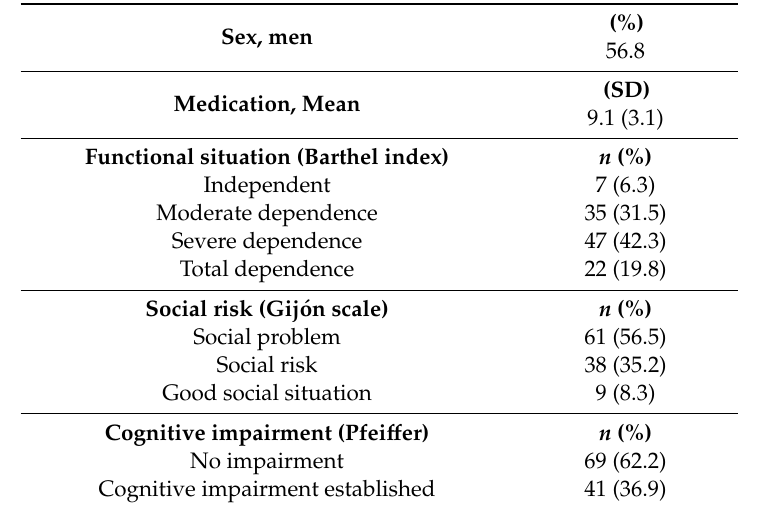
Table 1. Sample characteristics.